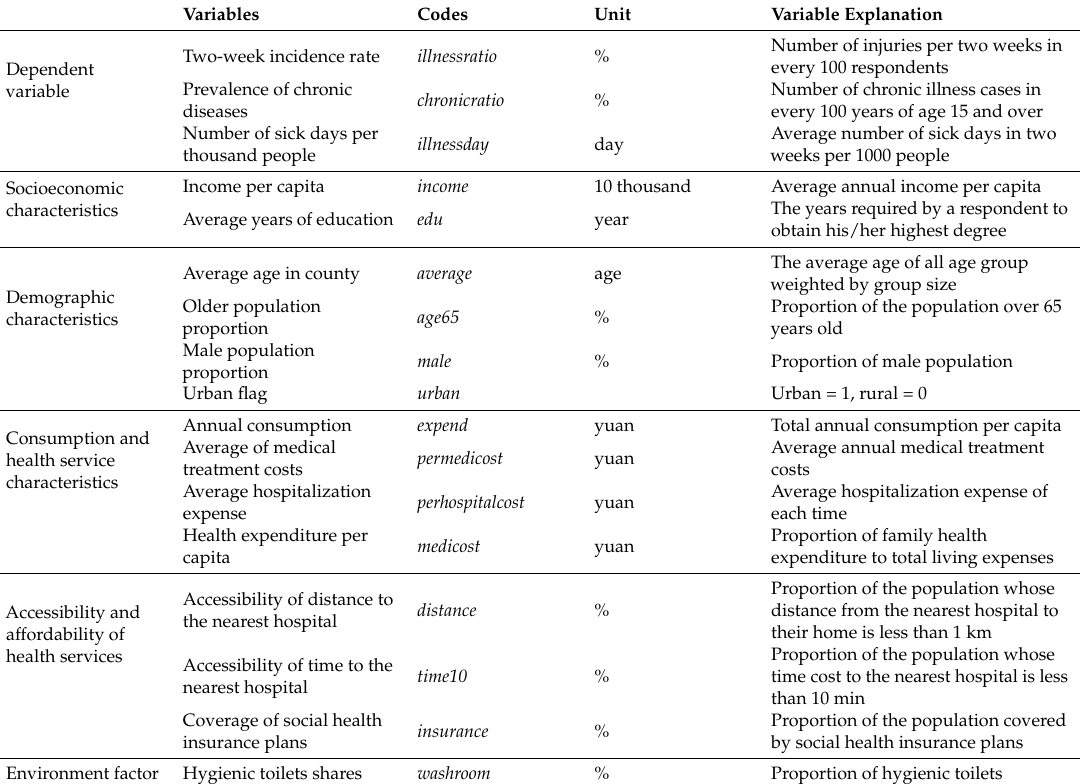
Table 1. Variables from National Health Services Survey (NHSS)